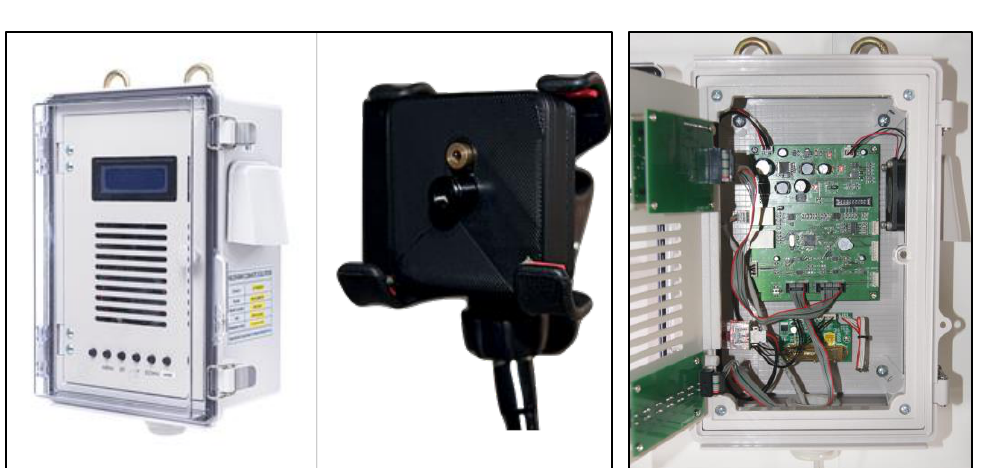
Figure A1. A prototype of new hardware for measuring leaf temperature. The hardware consisted of an information collection device and a non-contact infrared thermometer. RS485 MODBUS was used as the serial communication method, with a communication speed of up to 57,600 bps. A DC24V power supply was provided.